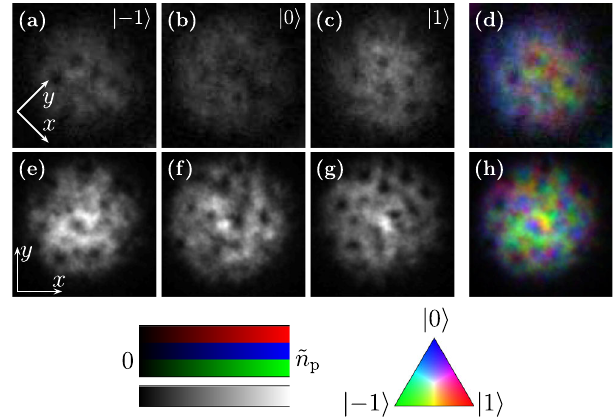
7. (a – d) Experimental column particle densities of − z - quantized spin states and (e – h) numerical column particle densities with a circularly rotating field zero in the xy plane corresponding to the magnetic field peak-to-peak amplitude of 1 mG and 60-Hz oscillation frequency. Here, the hold time is 100 ms. The first, second, and third columns correspond t hold ¼ to the spinor components ζ − 1 , ζ 0 , and ζ , respectively, and þ 1 the fourth column shows the corresponding composite images. 1 . 0 × 10 9 cm − 2 , In each panel, the peak particle density is ~ n p ¼ and the field of view is 228 × 228 μ m 2